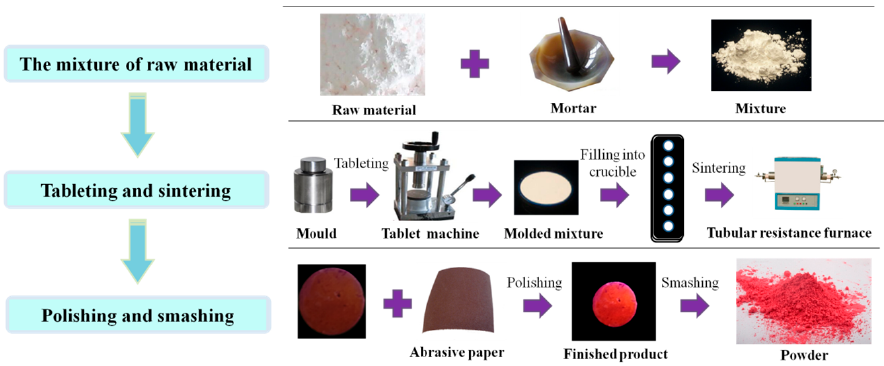
Figure 1. Synthetic route of Sr 2 Si 5 N 8 : Eu 2+ phosphors by the pellet method.